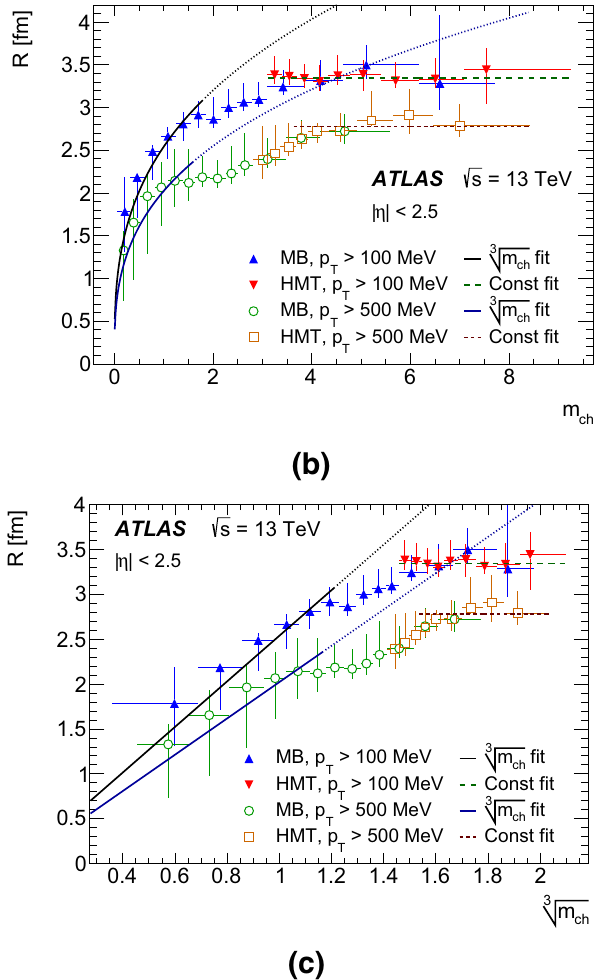
Fig. 4 a The dependence of the correlation strength, λ( m ch ) , on rescaled multiplicity, m ch , obtained from the exponential fit of the R 2 ( Q ) correlation functions for tracks with p T > 100 MeV and √ p T > 500 MeV at s = 13 TeV for the minimum-bias (MB) and high multiplicity track (HMT) data. b The dependence of the source radius, R ( m ch ) , on m ch . c The dependence of the R ( m ch ) on 3 The uncertainties represent the sum in quadrature of the statistical and asymmetric systematic contributions. The black and blue solid curves